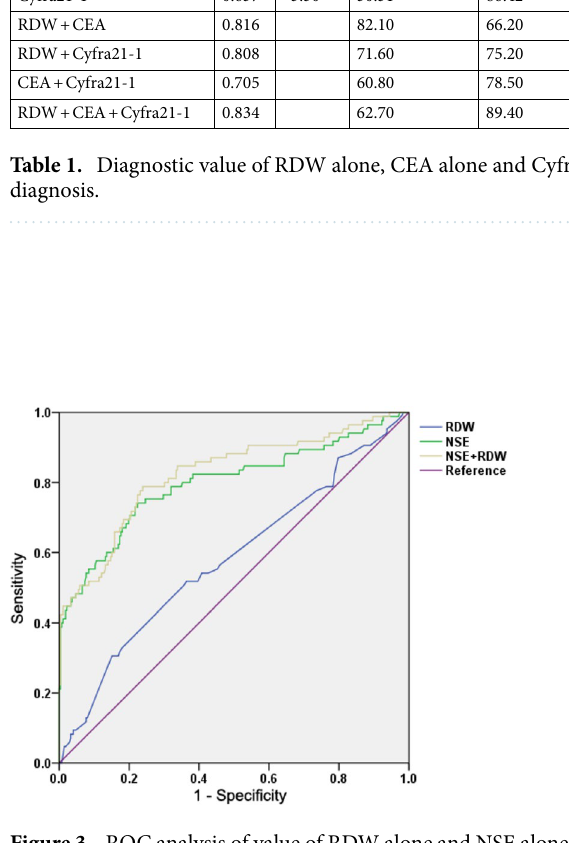
Figure 3. ROC analysis of value of RDW alone and NSE alone, and the combination in differential diagnosis between NSCLC and SCLC. RDW levels in 272 NSCLC patients and 85 SCLC patients were analyzed by ROC curve analysis (NSE levels of some patients is